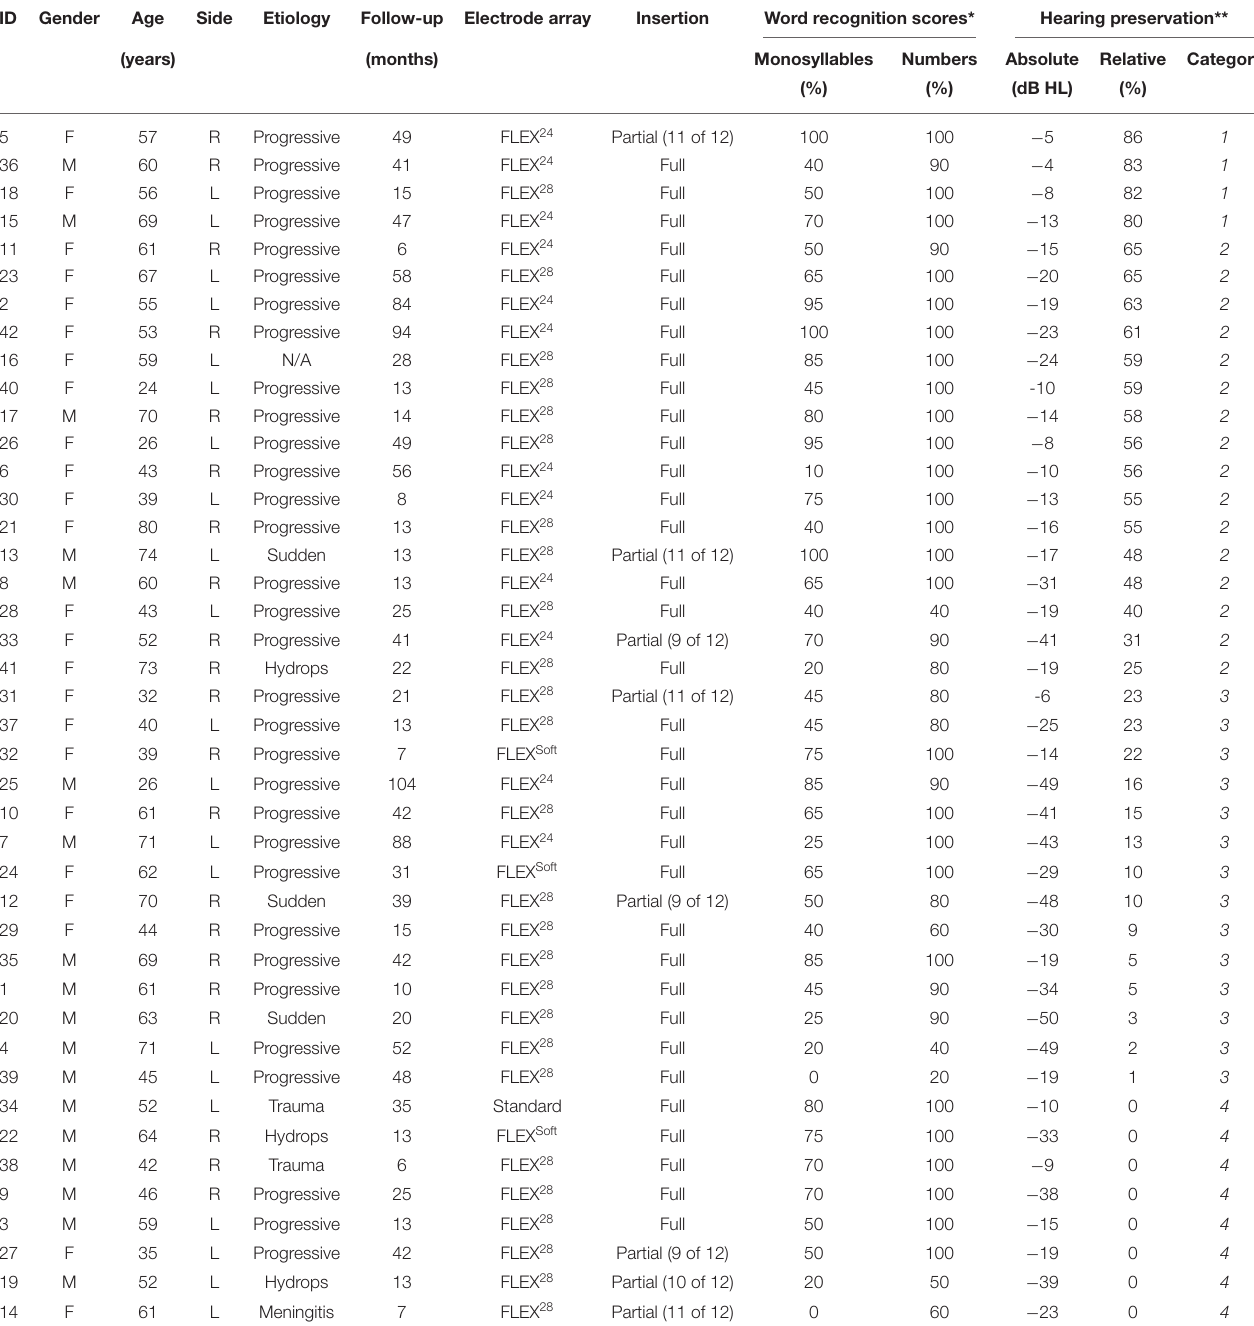
TABLE 1 | Subject demographics and functional outcomes, sorted by relative preservation of residual hearing after 6 months. F, female; M, male; R, right; L, left. ID Gender Etiology Follow-up Electrode array Insertion Word recognition